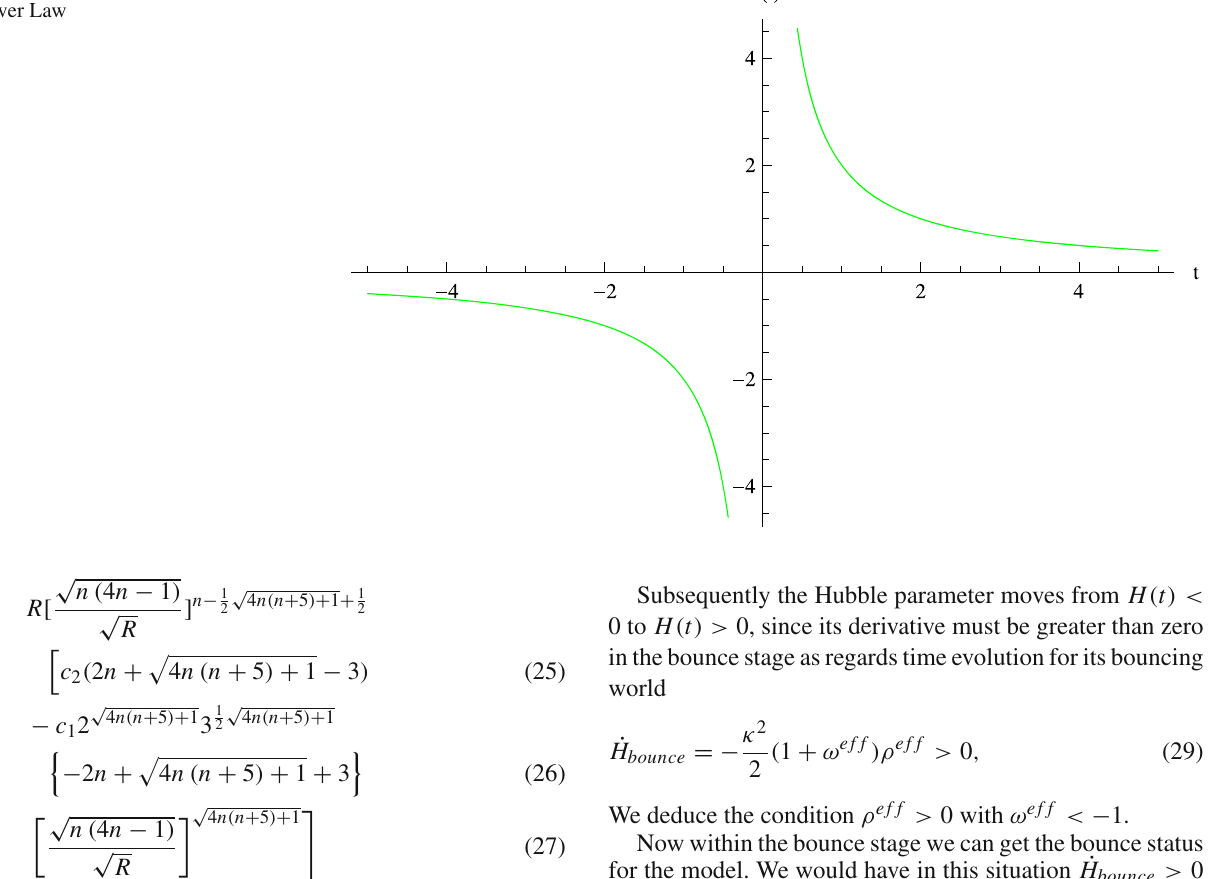
Fig. 1 Hubble parameter for Power